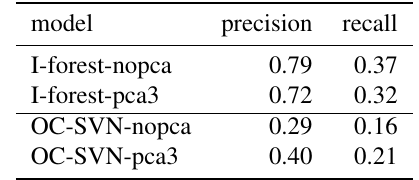
Table 2: Mean precision and recall for the unsupervised algorithms. Su ffi x -pca3 means the algorithms’ input data were pre-processed by PCA and the first three components were used and the -nopca su ffi x denotes an algorithm trained without any PCA